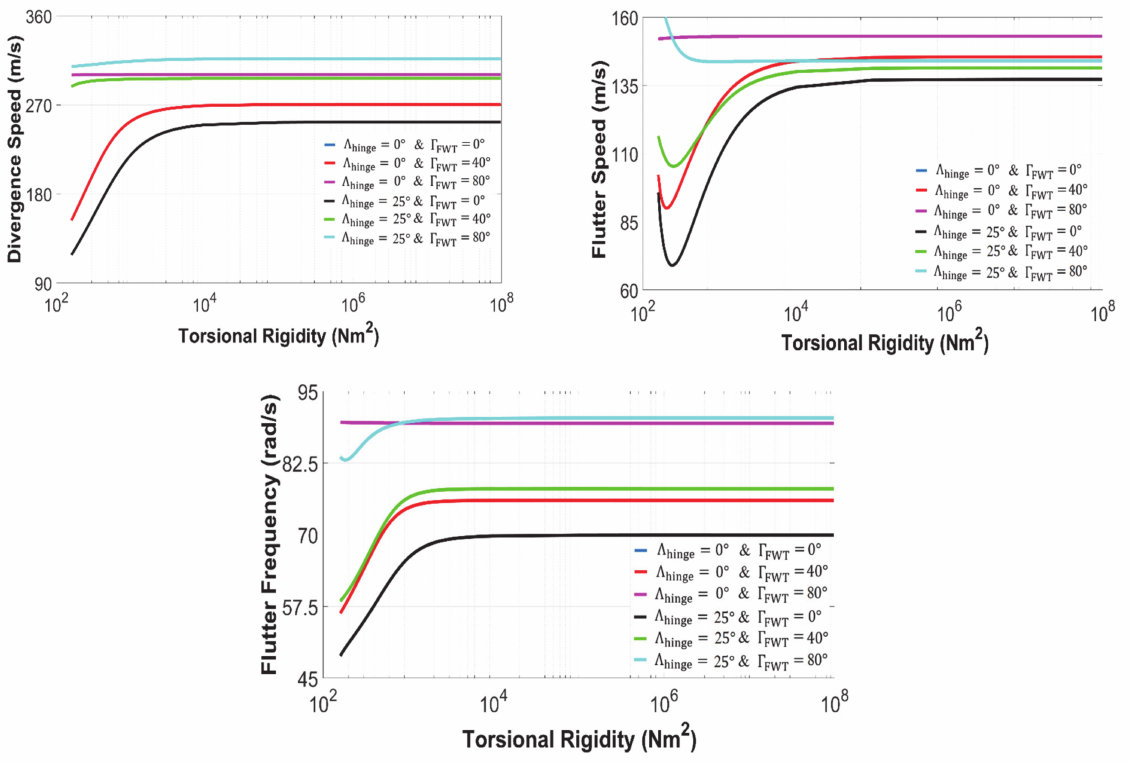
Figure 10. Variation of aeroelastic parameters with torsional rigidity of the hinge for a tip length of 1.016